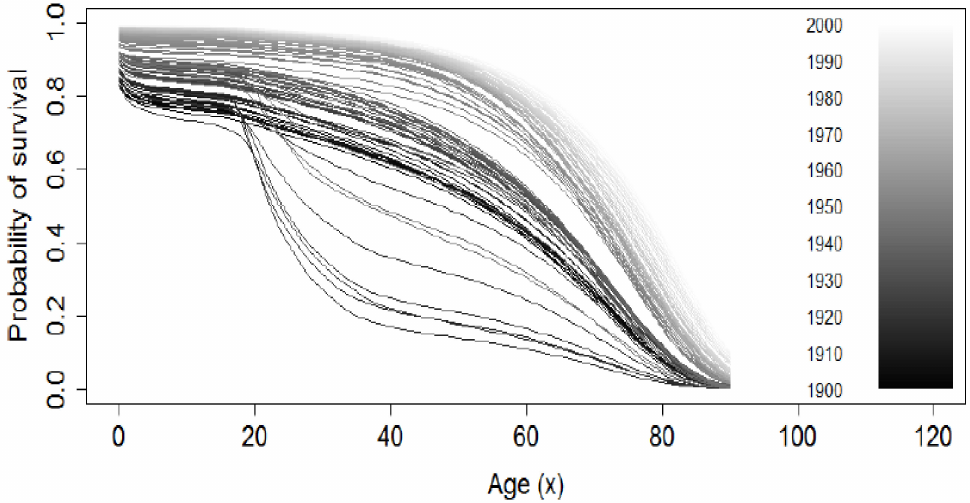
Figure 3. Probability of survival of French males from